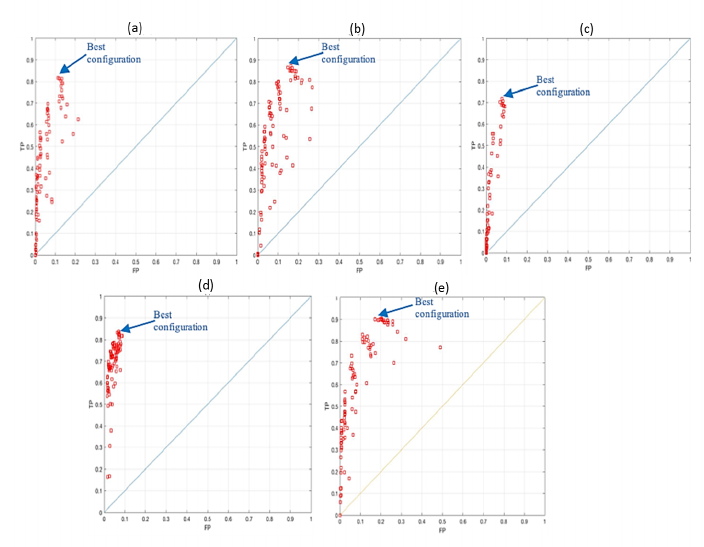
Figure 11. ROC curves for the NN optimisation. ( a ) results for class 1; ( b ) results for class 2; ( c ) results for class 3; ( d ) results for class 4; ( e ) results for class